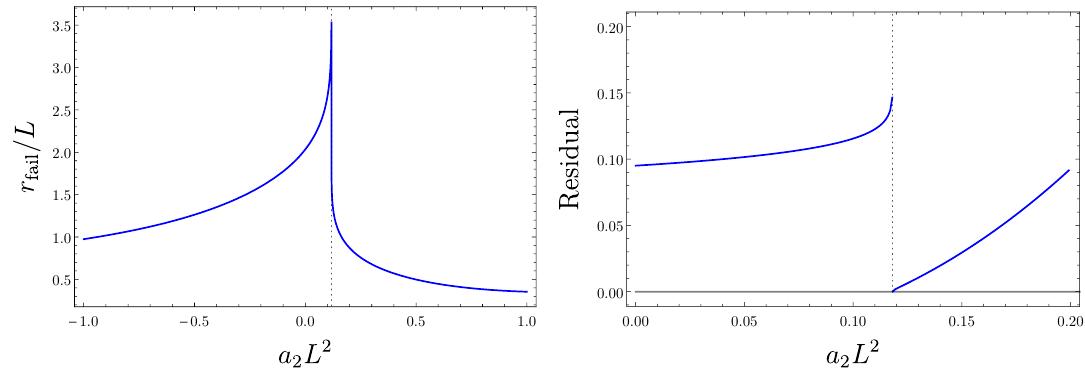
Figure 17 . Left: a plot of r fail the r value at which the numerical scheme fails vs. the shooting parameter a 2 . Right: a plot of the residual as a function of the shooting parameter a 2 . In both plots, the dotted line corresponds to a 2 L 2 = 0 : 1181855186708097. Both plots are for the case of NUT solutions in the quartic generalized quasi-topological theory for B = CP 2 with (cid:24) = (cid:0) 10, n=L = 1 = 3 and (cid:15) = 10 (cid:0) 2 L . A working precision of 40 was used in producing these particular